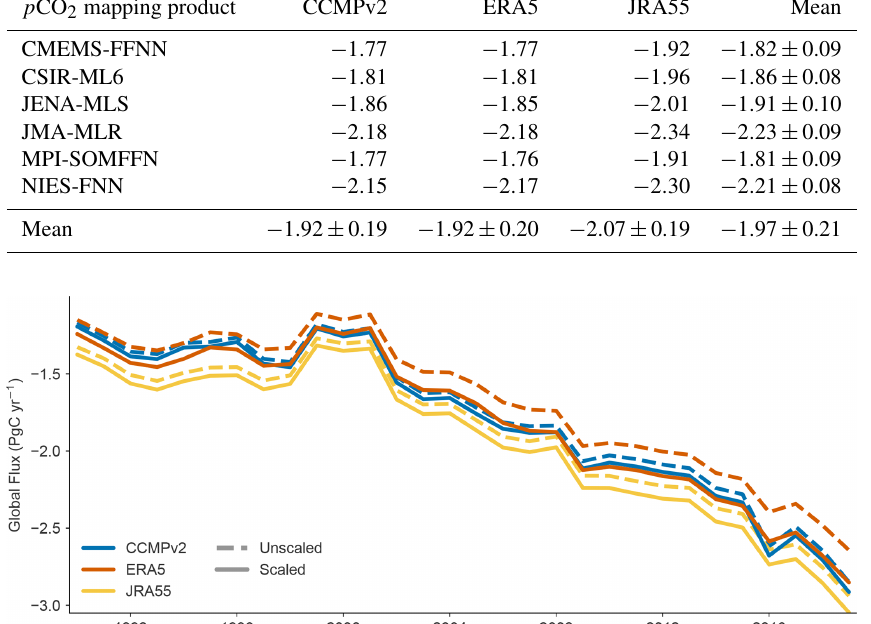
Table 4. Mean fluxes (PgCyr − 1 ) for each observational p CO 2 product over the period 1990–2019. Mean flux is calculated from filled coverage p CO 2 map and scaled gas exchange coefficient; global mean flux is for three wind products (CCMP2, ERA5, JRA55) and the average. The time series of the mean flux values for each product (rightmost column) are plotted in Fig. 5. p CO 2 mapping product